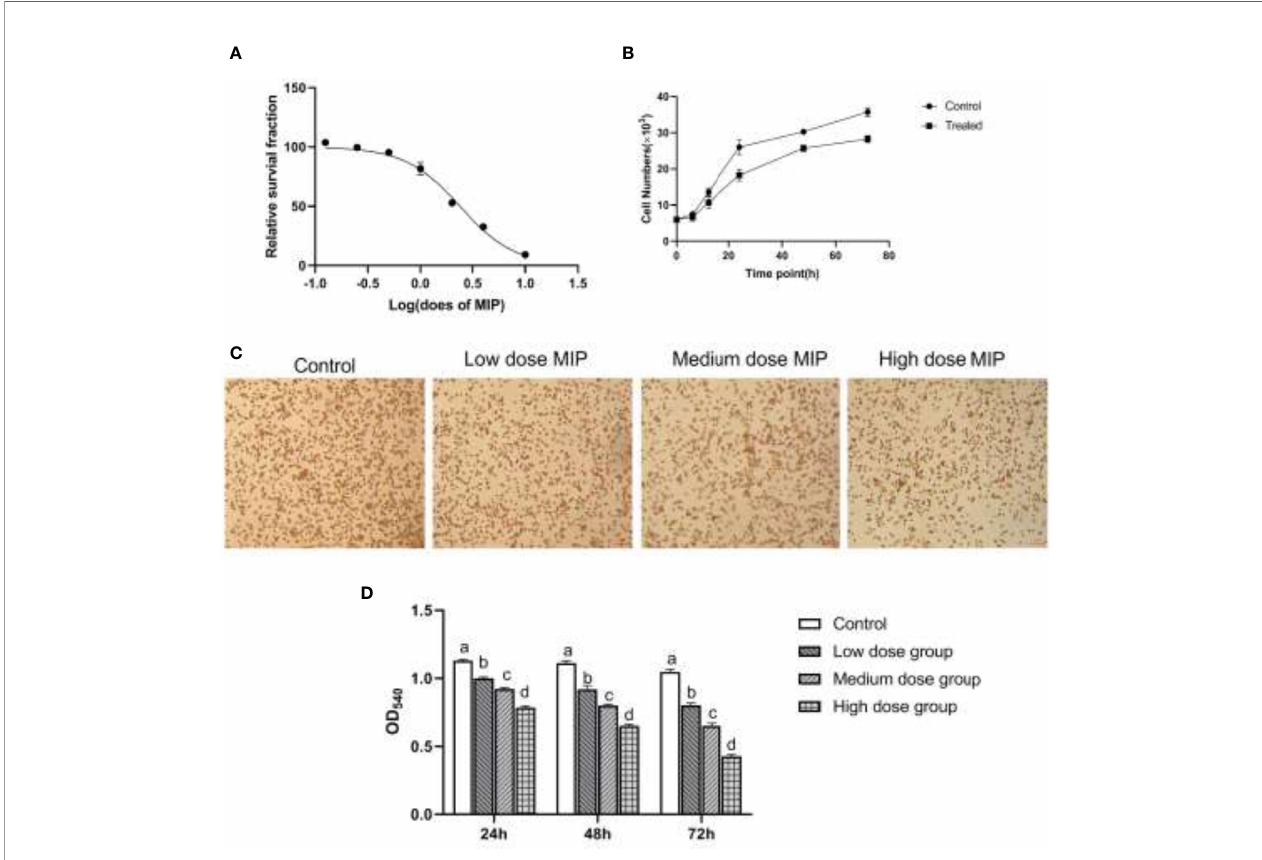
FIGURE 1 | MIP inhibits the proliferation and phagocytic activity of RAW264.7. (A) A dose-response study of MIP indicated IC50 as 2.384 ng/mL. (B) The proliferous capacity of RAW264.7 upon the treatment of MIP. (C) The cytological morphology of RAW264.7 from neutral red uptake assay at 24 h in the four groups (control cells; cells treated with 0.24 ng/ml MIP; cells treated with 0.48 ng/ml MIP; cells treated with 0.96 ng/ml MIP); (D) Semi-quantitative analysis of the phagocytosis of RAW264.7. The signi fi cant differences were marked by the alphabetic notation (a – d) by using ANOVA. In the control and different concentration treatment groups, the control is marked with the letter a; in the low-dose group, an average that is signi fi cantly different from it is marked with the letter b, otherwise, letter a and continuously marked with letters c and